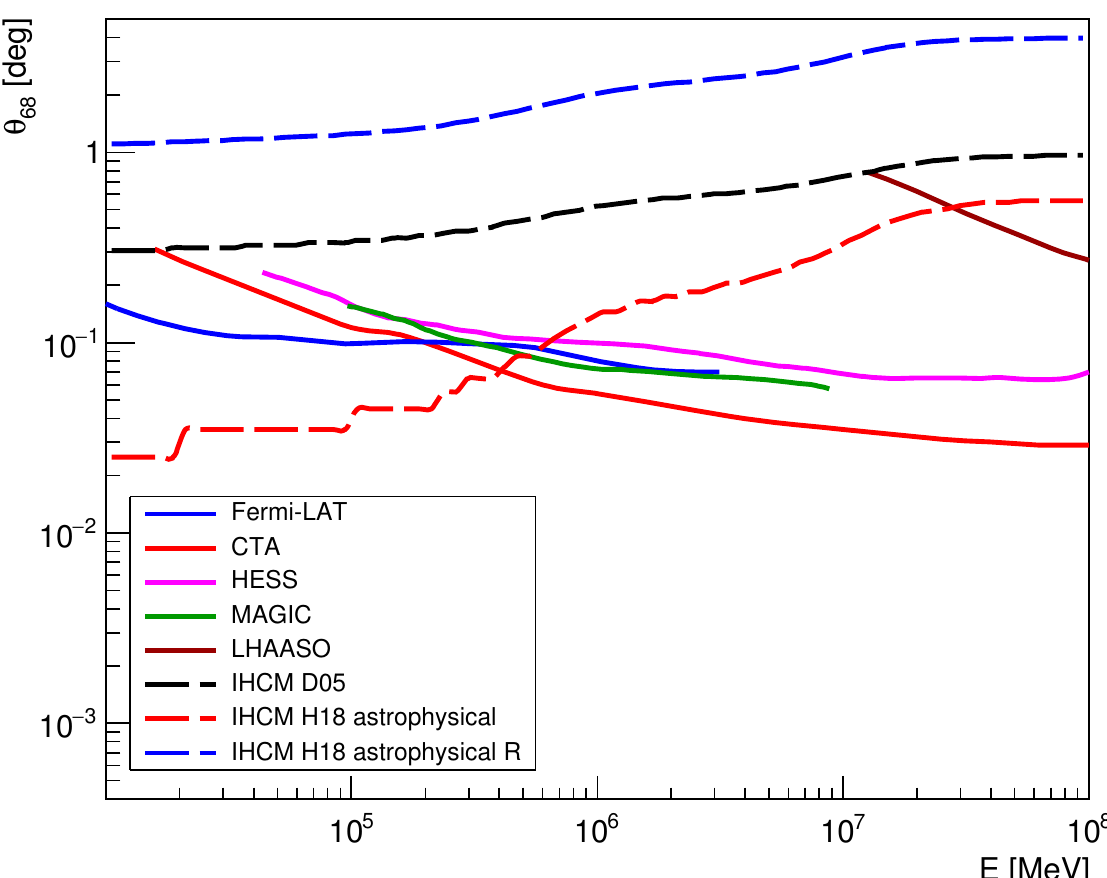
Figure 4. Angular resolution (68% containment angle) of various gamma-ray instruments (solid curves: blue curve denotes Fermi-LAT, red curve—CTA, magenta curve—H.E.S.S., green curve—MAGIC, brown curve—LHAASO) vs. the 68% containment angle of the observable emission in the framework of IHCM assuming different EGMF models (dashed curves: black curve denotes D05 model, red curve—astrophysical model (H18), blue curve—astrophysical R model